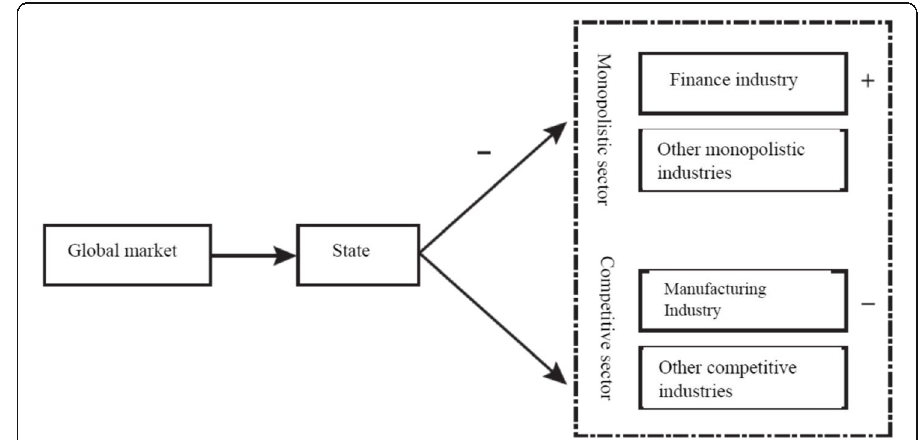
Fig. 2 Global market, state, and segmentation of the labor